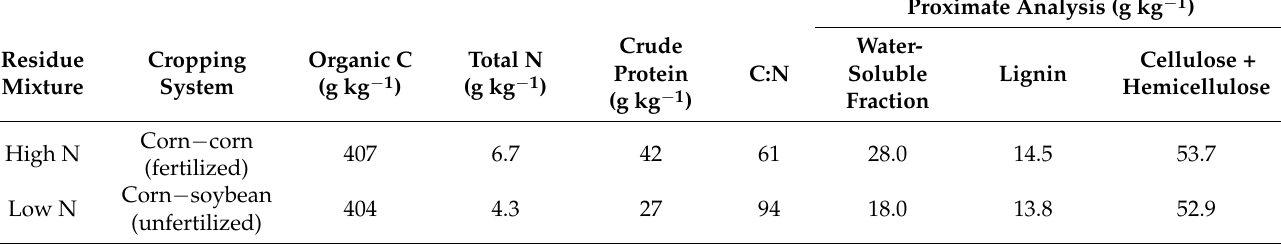
Table 2. Characterization of corn residue mixtures used in incubation study. Data reported as a mean of duplicate or triplicate determinations. Values for total N and water-soluble fraction differ significantly at p < 0.001. Crude protein calculated as total N × 6.25